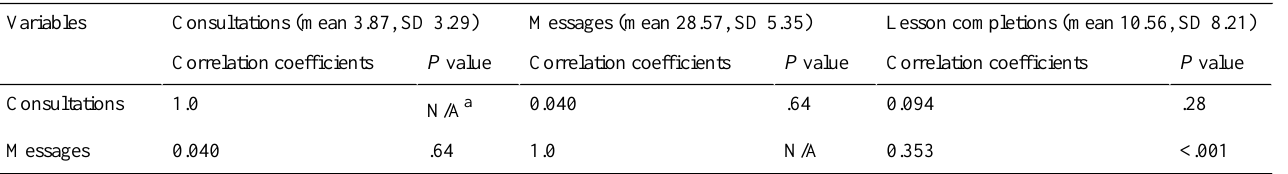
Table 2. Summary statistics for program engagement (N=131).